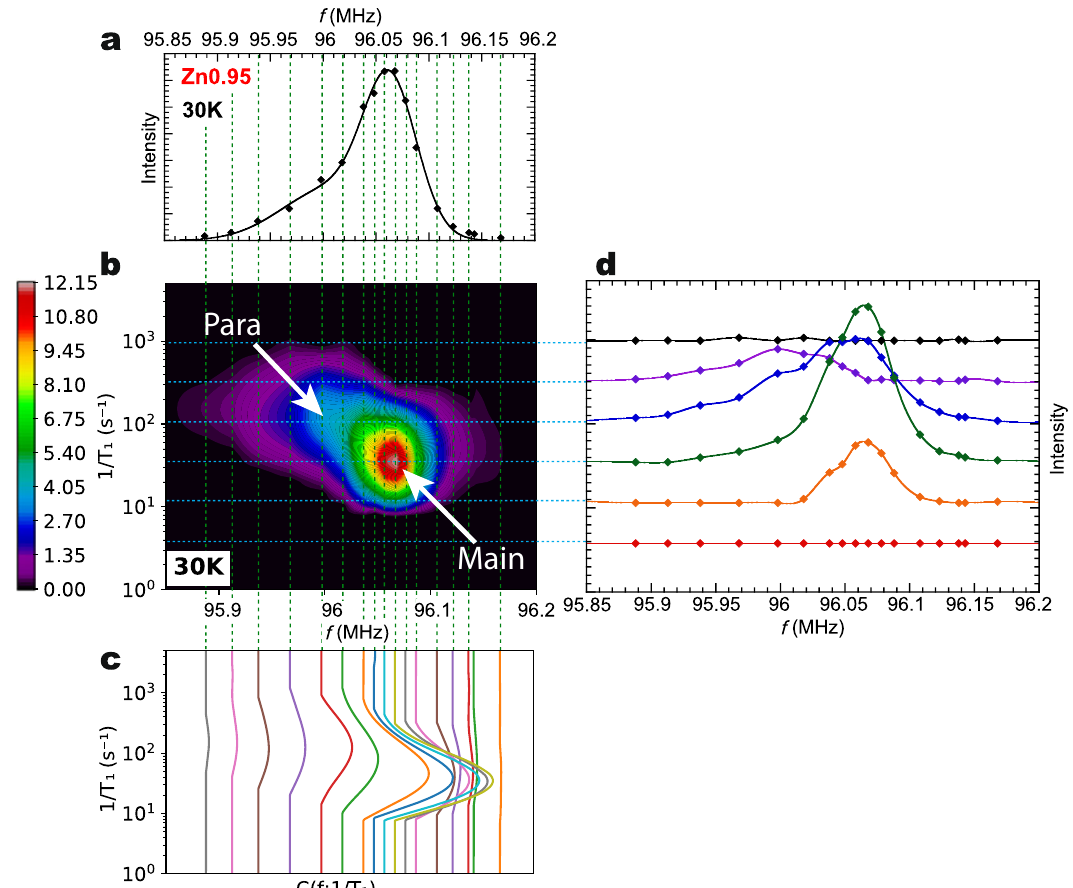
Fig. 6 Two-dimensional correlation map C ( f ; 1/ T 1 ) of Zn 0.95 and 1/ T 1 -resolved NMR lineshapes. a Conventional one-dimensional NMR lineshape of all 19 F nuclear spins observed for Zn 0.95 at 30 K. b Example of the color contour map of the frequency f vs. 1/ T 1 correlation function C ( f ; 1/ T 1 ) at 30 K deduced from the ILT measurements of P (1/ T 1 ) at various frequencies within the lineshape. A side peak marked as Para emerges at low temperatures centered around f = 96.02 MHz or below, with enhanced 1/ T 1 ≃ 100 s − 1 . c Vertical slice of the color contour map of C ( f ; 1/ T 1 ) at a fi xed frequency f is nothing but the one-dimensional P (1/ T 1 ) result at that frequency. For example, C ( f ; 1/ T 1 ) sliced vertically at 19 f peak = 96.06 MHz is P (1/ T 1 ) at 30 K presented in Fig. 5a. d Horizontal slice of C ( f ; 1/ T 1 ) at a fi xed value of 1/ T 1 yields the 1/ T 1 - resolved NMR lineshape with the contributions from only the 19 F nuclear spins with that particular value of 1/ T 1 . Note that the 19 F NMR 1/ T 1 - resolved lineshape for 1/ T 1 = 300 s − 1 is peaked at 96.02 MHz, which is lower than the main peak frequency 19 f peak ≃ 96.06 MHz. The Knight shift 19 K para arises from the